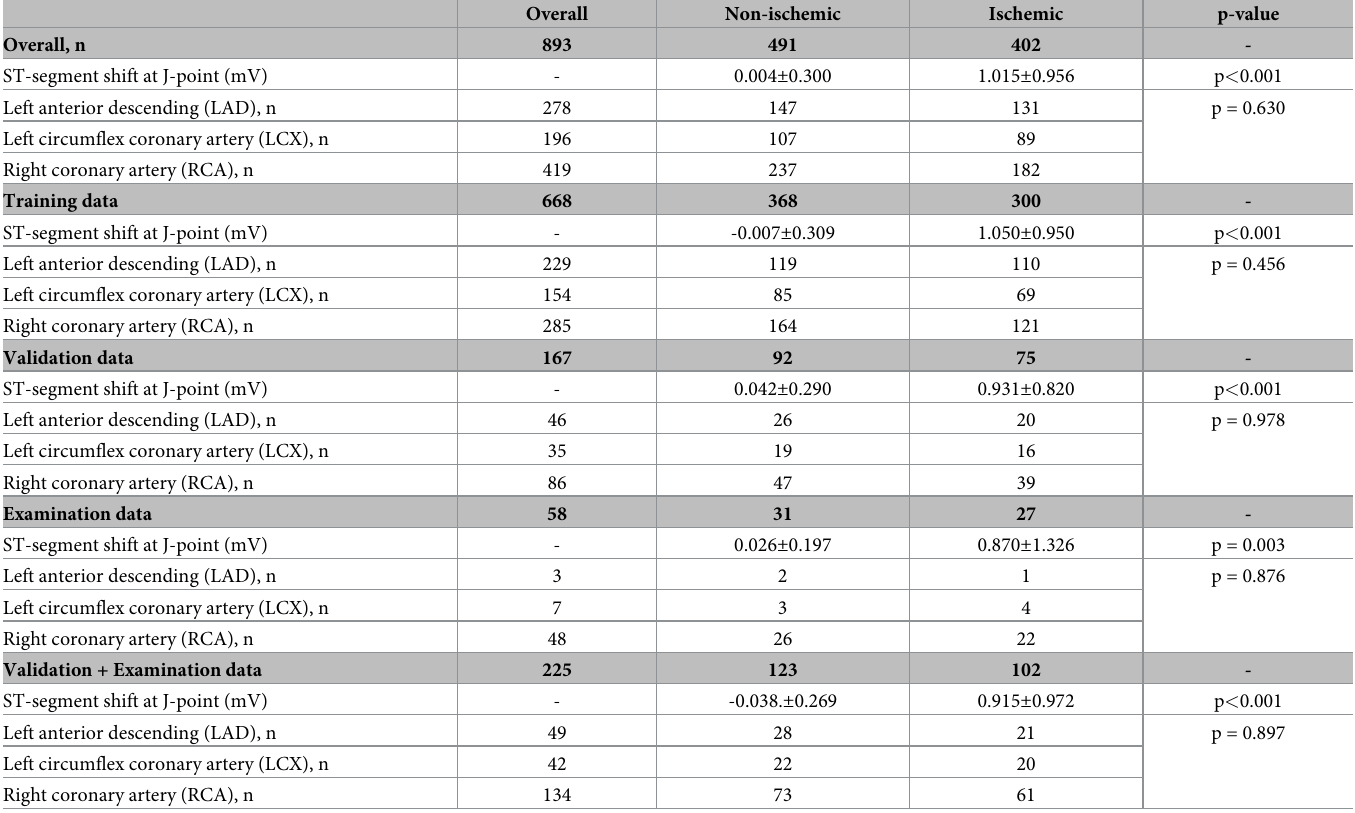
Table 2. ST–segment shift and target vessel